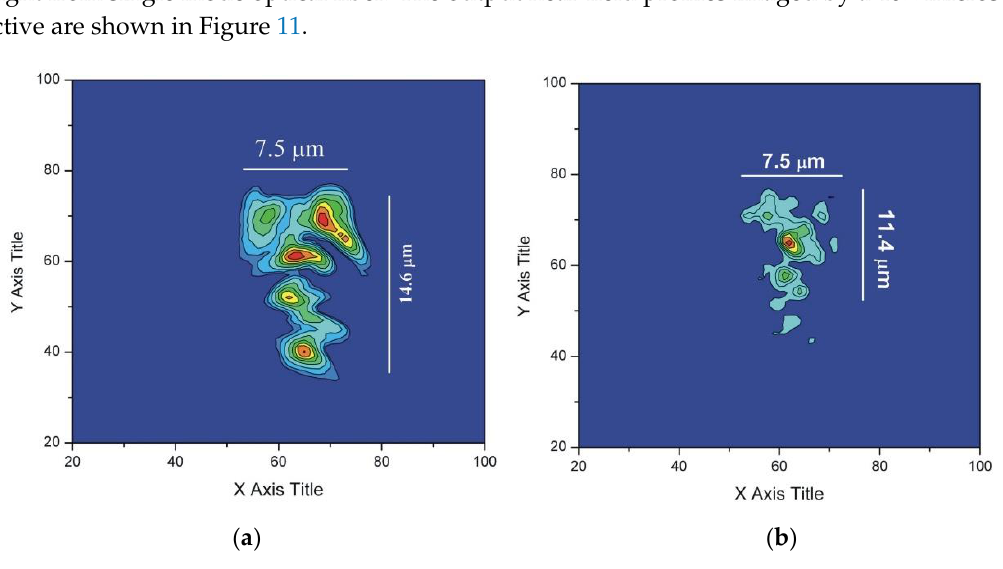
Figure 11. Near-field beam profiles for ( a ) 633 nm and ( b ) 975 nm from a 7 μ m lithium niobate channel with lithium tantalate as the substrate; imaging with a 40× microscope objective.